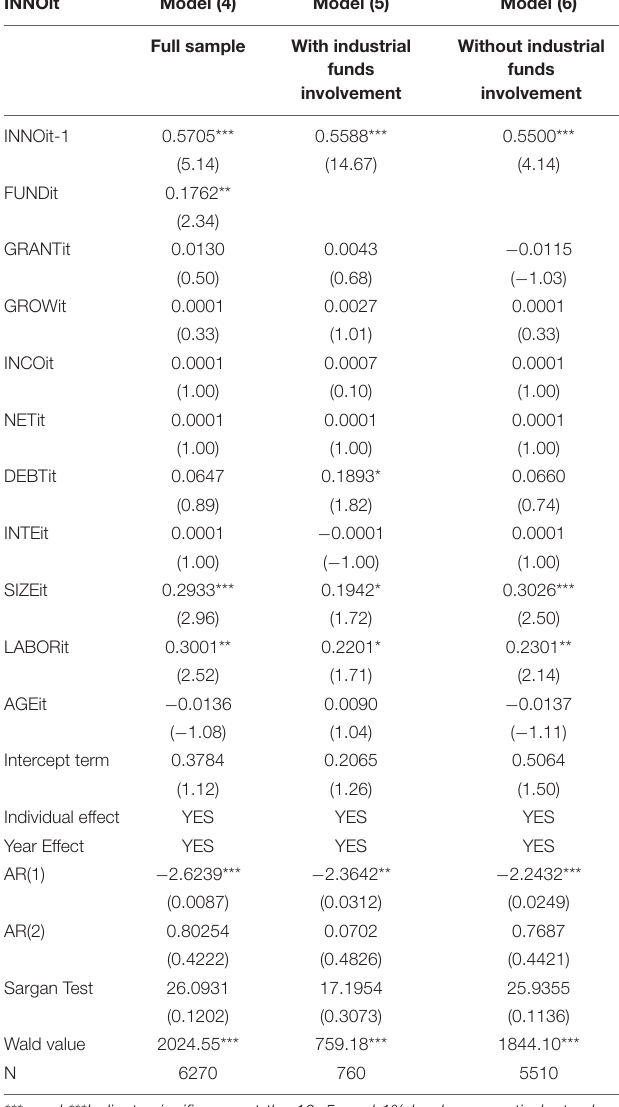
TABLE 3 | Robustness test